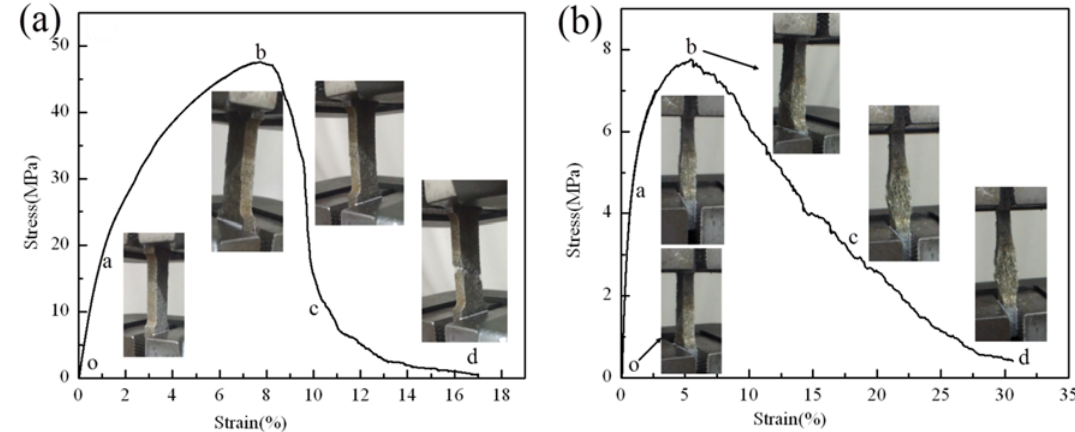
Figure 4. Two types of typical uniaxial tension stress-strain curves and failure process of